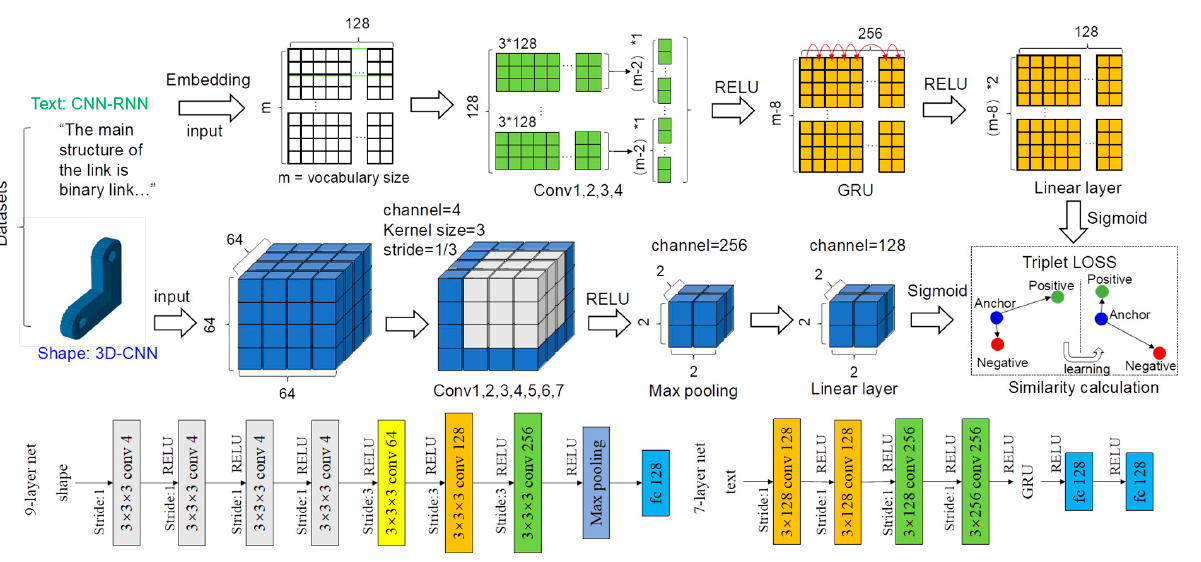
Figure 6. The overall structure of the text2shape deep retrieval model.